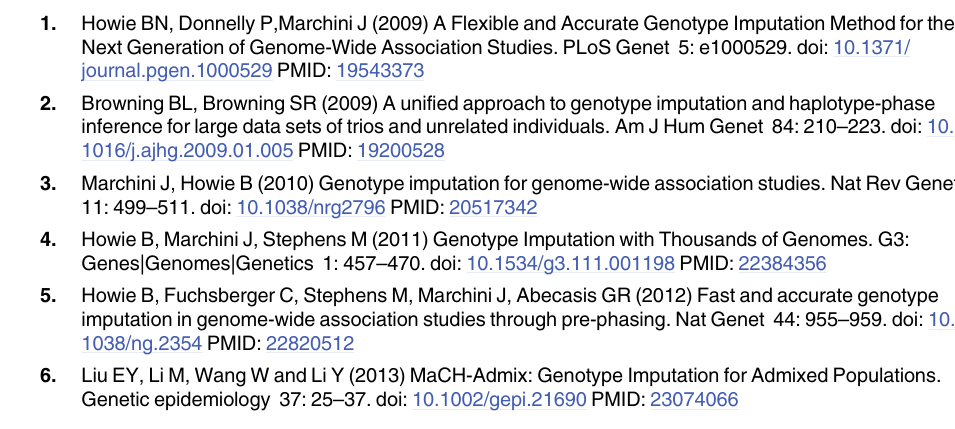
variants with MAF > 5% (N = 475) are found in panel D, E, and F. These results were generated using Omni SNP coverage. The line y = x is denoted in red. S11 Fig. Scatterplots of IQS, squared correlation, and IMPUTE2 INFO using the cosmopol- itan reference panel and the European American nicotine dependence study sample for chromosome 15. Data for all 1,253 variants are displayed in panel A, B, and C while the results for variants with MAF > 5% (N = 259) are found in panel D, E, and F. These results were gener- ated using Omni SNP coverage. The line y = x is denoted in red. S1 Table. Sub-populations in the BEAGLE and IMPUTE2 AFR and EUR reference panels. S2 Table. Numbers of SNPs in the 1000 Genomes study samples. Study sample variants were those found on each commercially available SNP array for the 2 MB chromosomal regions of interest. Only variants with dbSNP identifiers are listed in the number of variants in the refer- ence panel column. S3 Table. Polymorphic, imputed SNPs used in the comparison of accuracy measures. These variants were found in the 2 MB chromosomal regions of interest using 1000 Genomes as the study sample and were imputed using Omni 2.5